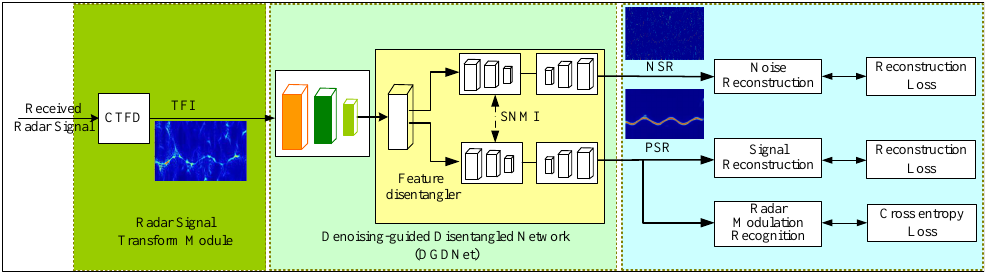
Figure 1. The overall framework of the